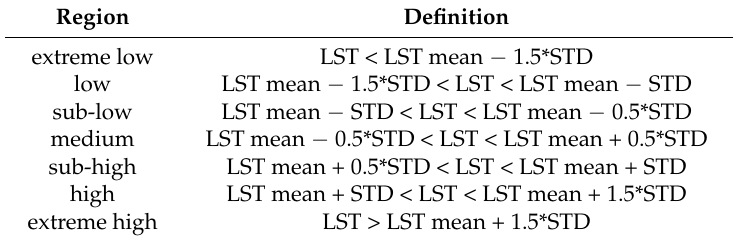
Table 2. Definition of land surface temperature region. LST: land surface temperature; LST mean; average LST; STD: standard deviation.